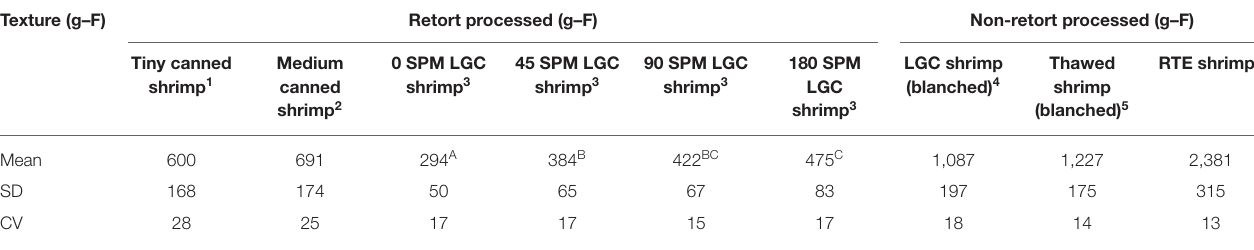
TABLE 3 | Firmness of commercial shrimp and in-house retort-processed Louisiana Gulf Coast (LGC) brown shrimp. Texture